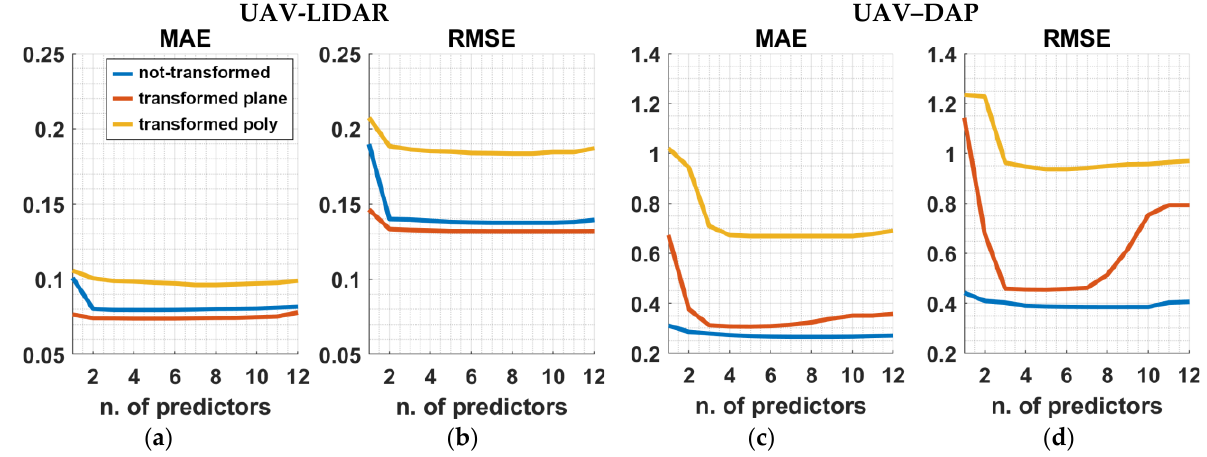
Figure 4. Error metrics (i.e., MAE and RMSE ) obtained by using a different number of predictors for the multiple linear regression. The errors are reported for all the point clouds [i.e., UAV-LIDAR, in ( a , b ) and UAV–DAP, in ( c , d )], and transformations (i.e., non-transformed, transformed plane, and transformed polynomial surface, blue, orange and yellow lines, respectively) considered in this study.